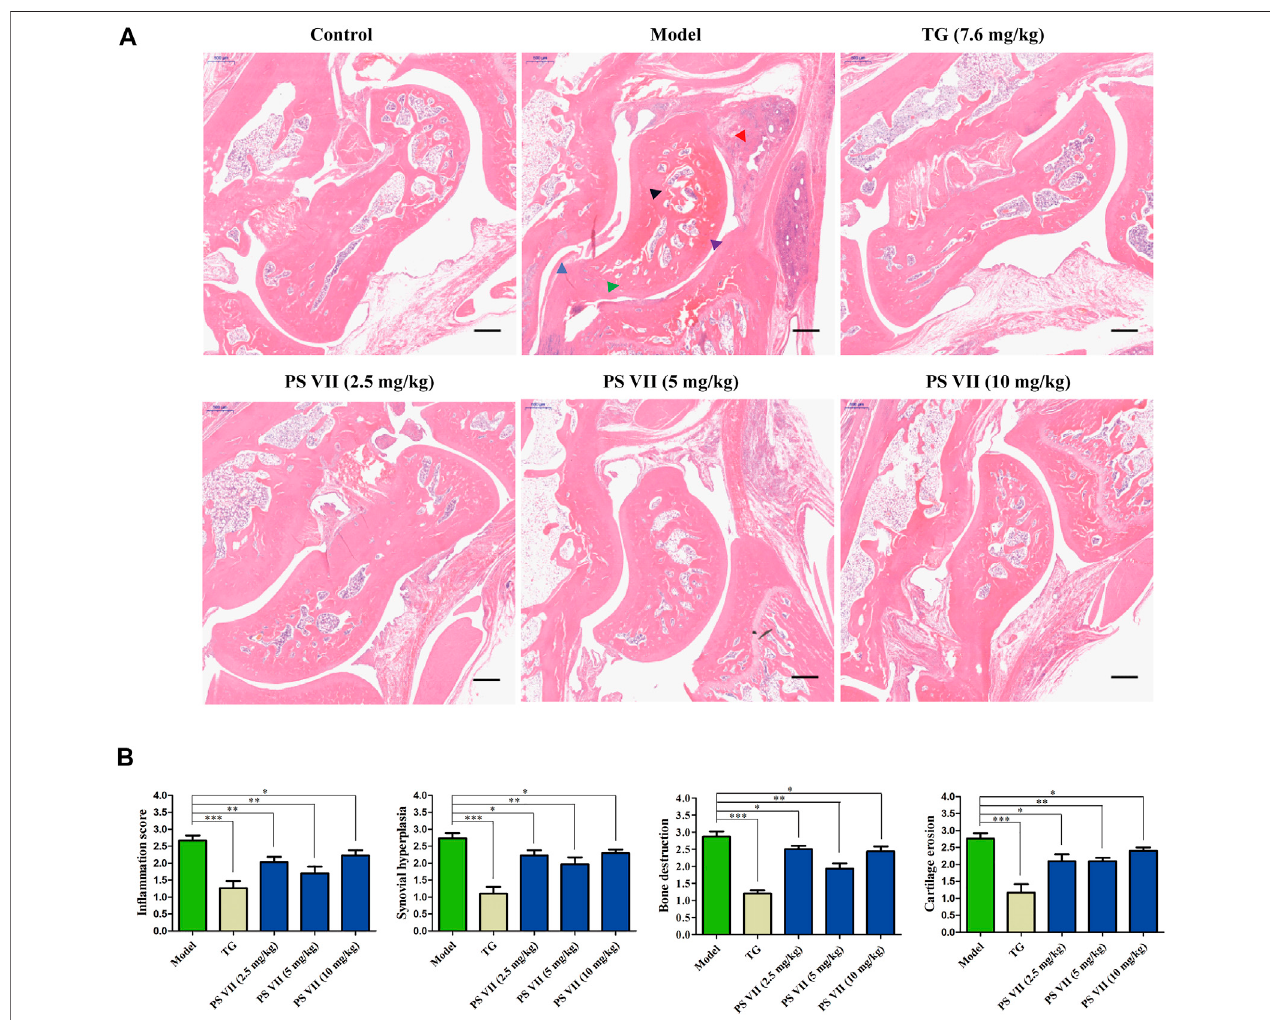
FIGURE 11 | Effects of PS VII on the pathological changes of AIA rats. (A) Hematoxylin and eosin (HE) stained representative sections of rat ankle joints from different groups. (B) Determine the histological score as described in the Materials and Methods section. Purple arrow: joint cavity; blue arrow: synovial hyperplasia; red arrow: in fl ammatory cell in fi ltration; black arrow: bone erosion; green arrow: cartilage destruction. Data are expressed as mean ± SD ( n (cid:2) 3). Compared with the model group, * p < 0.05, ** p < 0.01 and *** p < 0.001.